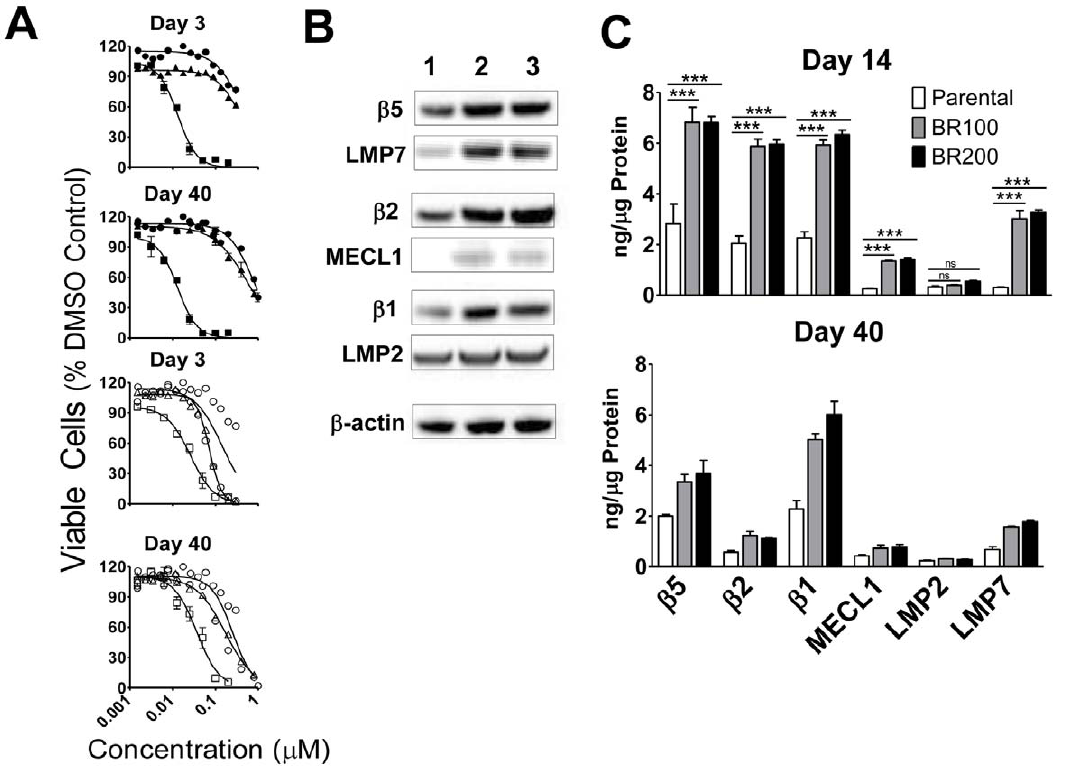
N , # ) Figure 1. Altered proteasome expression in bortezomib-resistant HT-29 cells. (A) Parental ( & , % ), BR100 ( m , D ), and BR200 cells ( were cultured for 3 or 40 days in the absence of drug prior to exposure to varying concentrations (1 nM–1 m M) of bortezomib (closed symbols) or carfilzomib (open symbols) for 72 hrs. Viability was normalized to DMSO controls and data are presented as mean viability of triplicate cultures ( 6 S.E.M). Data is from 1 of 3 replicate experiments with similar results. (B) Western blot analysis of constitutive and immunoproteasome active site subunits in parental (1), BR100 (2), and BR200 (3) cells cultured in the absence of drug for 14 days. b -actin or GAPDH was used as an to verify equal loading. (C) Constitutive and immunoproteasome subunit levels (ng subunit/ m g total protein) in parental, BR100 and BR200 cell lines cultured in the absence of drug for 14 or 40 days were measured using ProCISE. Data at day 14 are presented as mean 6 S.D. of 3 independent experiments. ***= P , 0.001 by one-way ANOVA followed by Bonferroni’s Multiple Comparison Test. Data at day 40 is representative of one experiment. doi:10.1371/journal.pone.0027996.g001 HT-29 cells as does bortezomib (Figure 1 and Table 1). Over the factor of , 5 at all time points. These data suggest that inhibition 40 day period, carfilzomib demonstrated relatively potent in these solid tumor cells can be overcome by other classes of cytotoxicity in both the BR100 and BR200 cells, with a resistance proteasome inhibitors. Table 1. Cell viability of HT-29, BR100 and BR200 cell lines over a 40-day